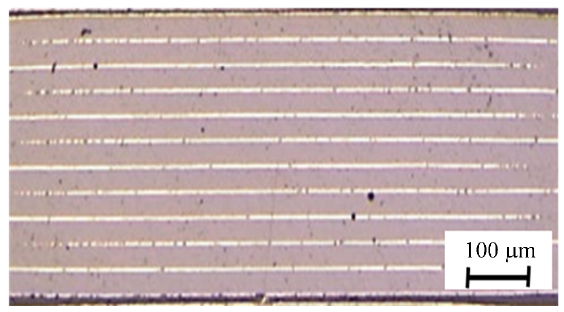
Figure 3. Optical microscope image of cross section of multilayer KNN ‐ CZ ‐ 2 ceramic structure.